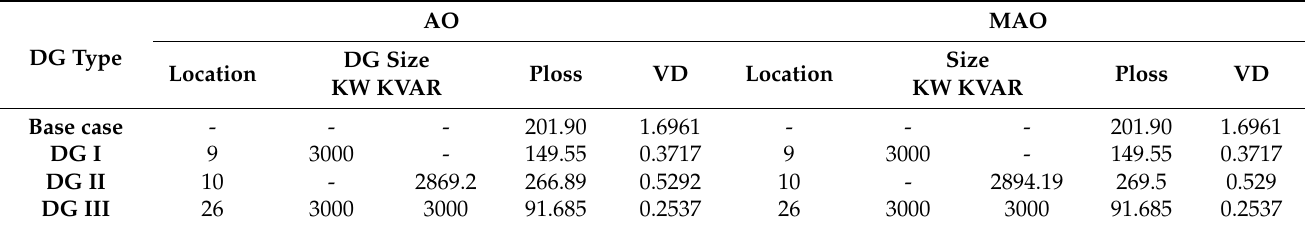
Table 14. Case 2: optimal DG allocation based on voltage deviation.